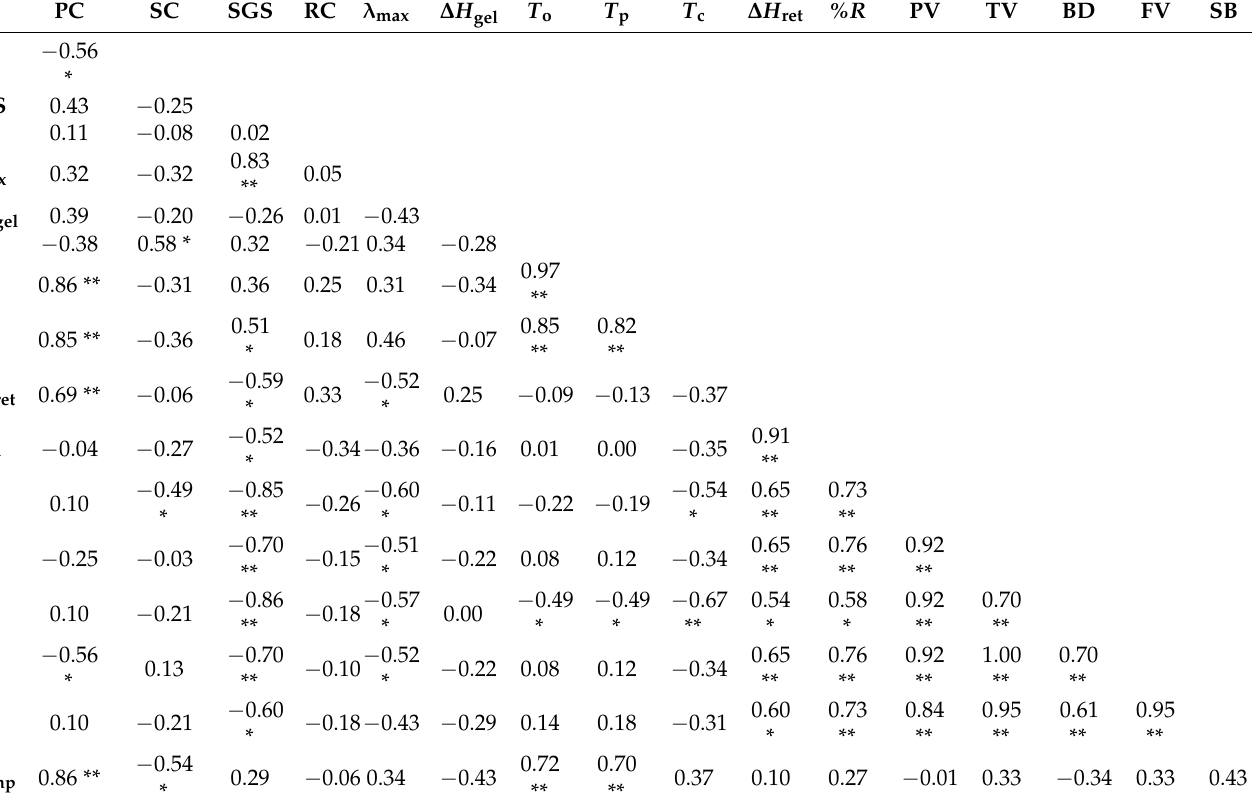
Table 3. Correlation coefficients between various characteristics (n =